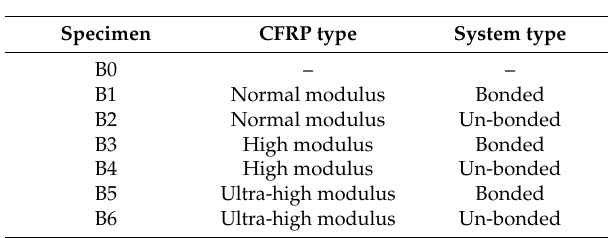
Table 5. Static test